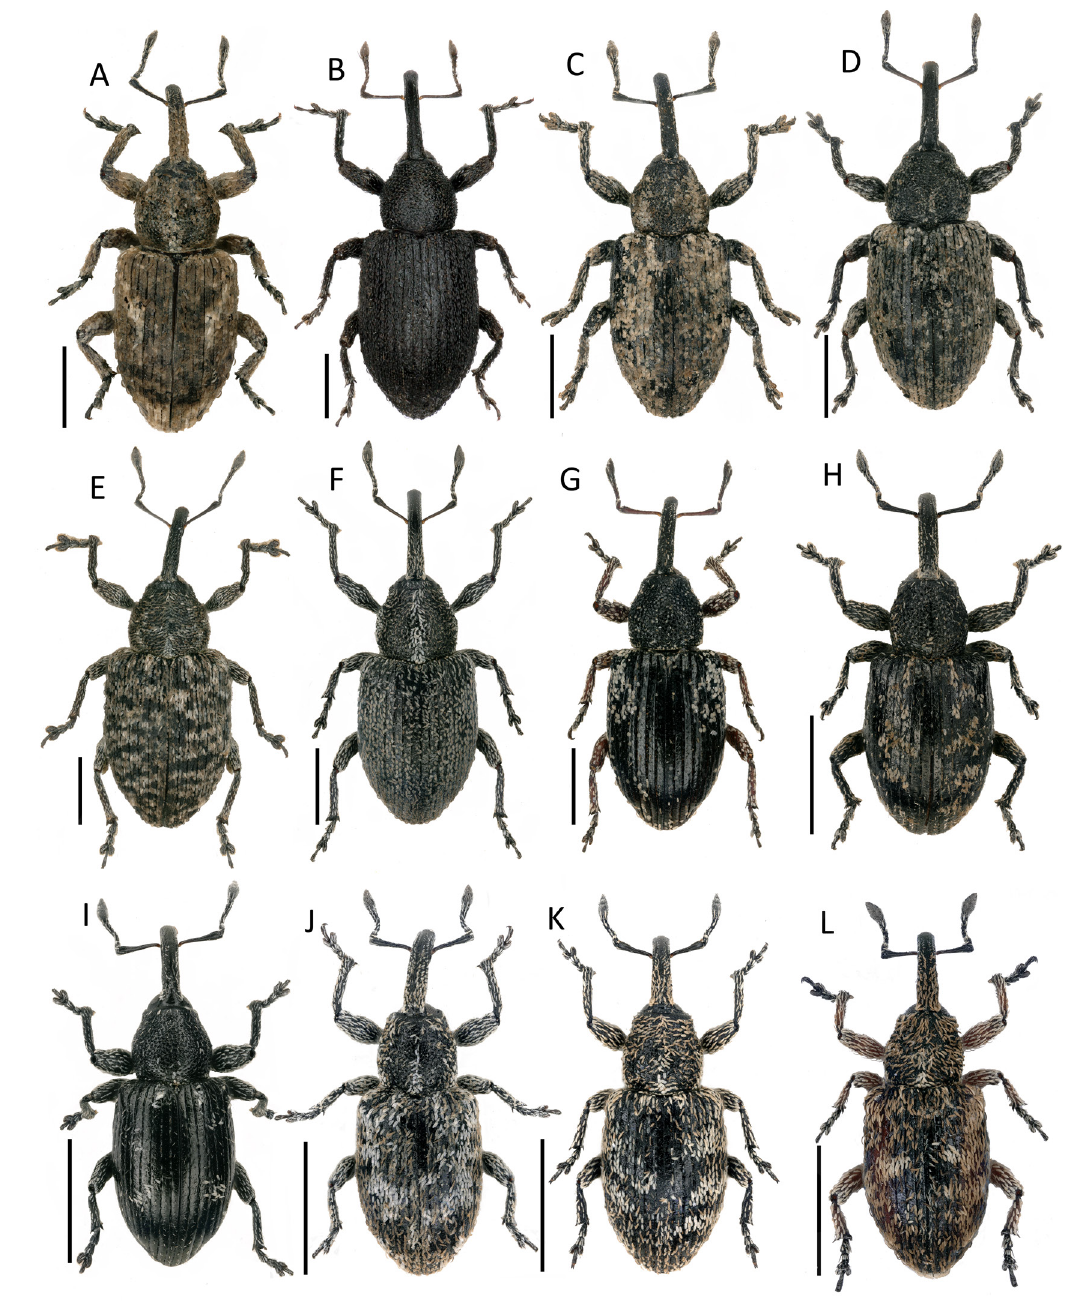
Fig. 1. Habitus of species of Smicronychini from southern Africa (Part 1). A . Sharpia madibai sp. nov., ♂, holotype (SAMC). B . Afrosmicronyx cycnii sp. nov., ♂, holotype (SAMC). C . Afrosmicronyx louwi sp. nov., ♂, holotype (SAMC). D . Afrosmicronyx marshalli sp. nov., ♂, holotype (SANC). E . Afrosmicronyx nebulosipennis sp. nov., ♂, holotype (BMNH). F . Smicronyx gracilipes sp. nov., ♀, holotype (SAMC). G . Smicronyx similis sp. nov., ♂, holotype (SANC). H . Smicronyx pseudocoecus sp. nov., ♂, holotype (SAMC). I . Smicronyx paucisquamis sp. nov., ♂, holotype (SAMC). J . Smicronyx fallax (Gyllenhal, 1836), ♂, neotype (NHRS). K . Smicronyx australis sp. nov., ♂, holotype (SAMC). L . Smicronyx pauperculus Wollaston, 1864, ♂, specimen from Tanzania. Scale bars: 1